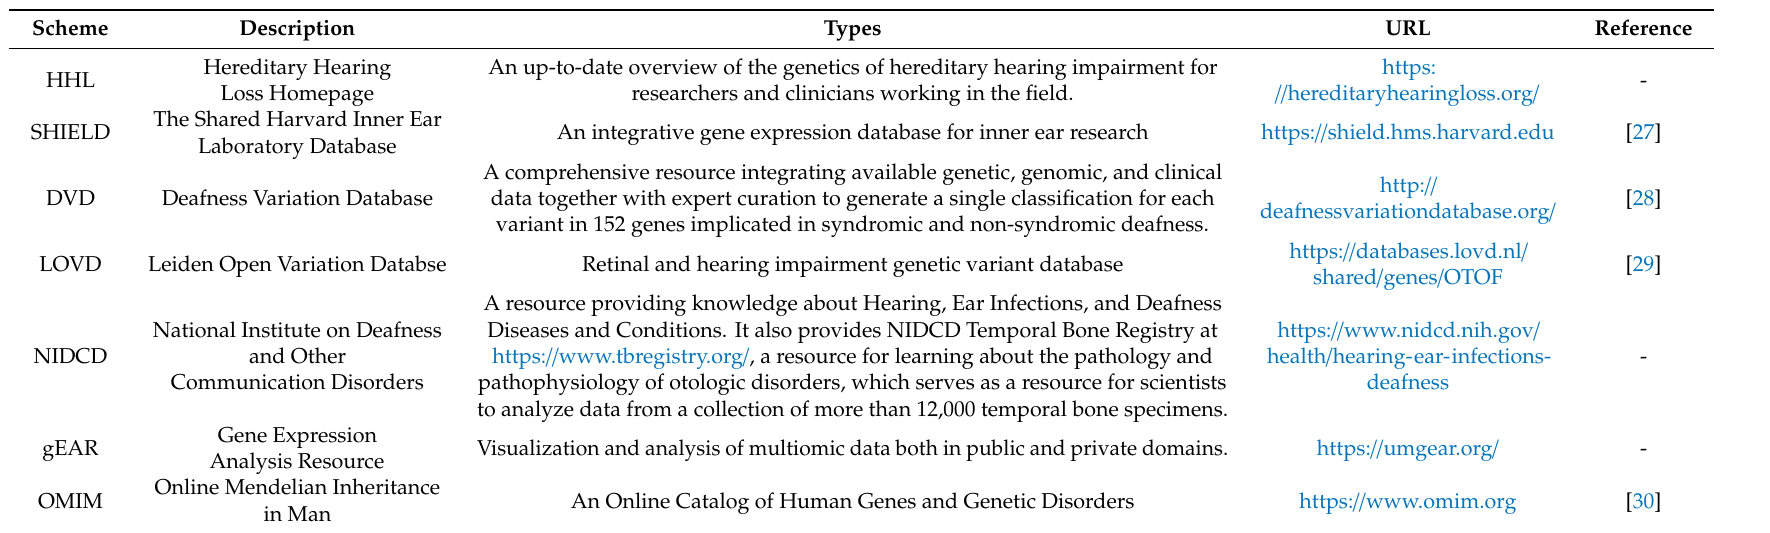
Table 3. Some existing online hearing impairment